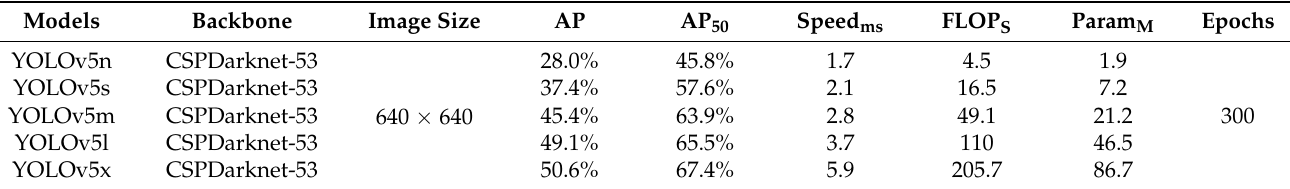
Table 2. Description of the YOLOv5